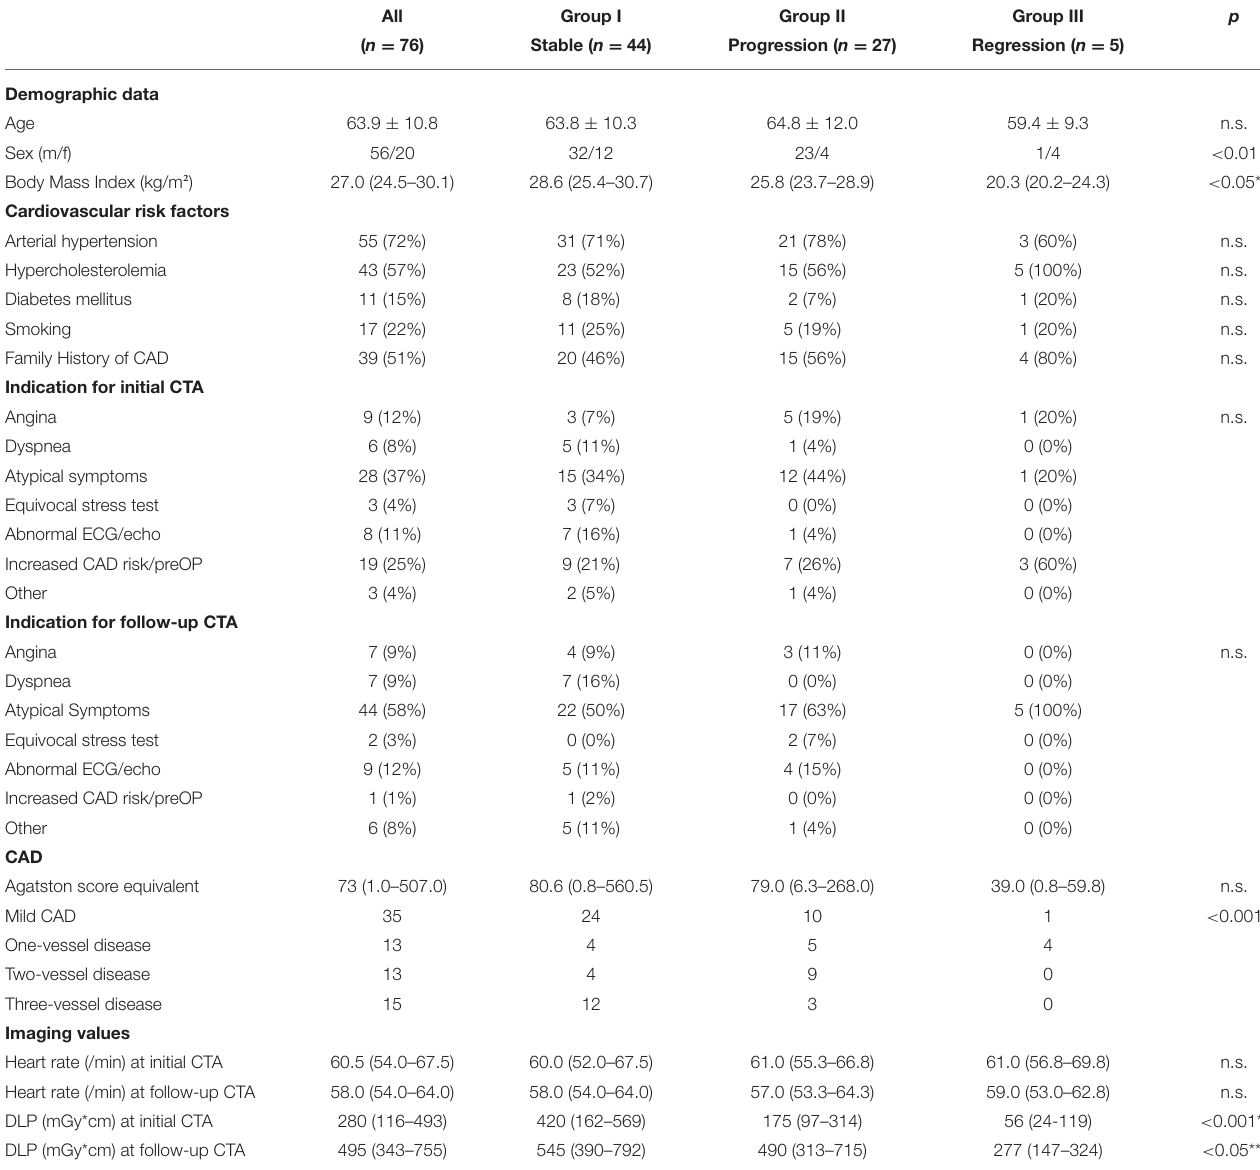
TABLE 1 | Characteristics of the patients and CTA